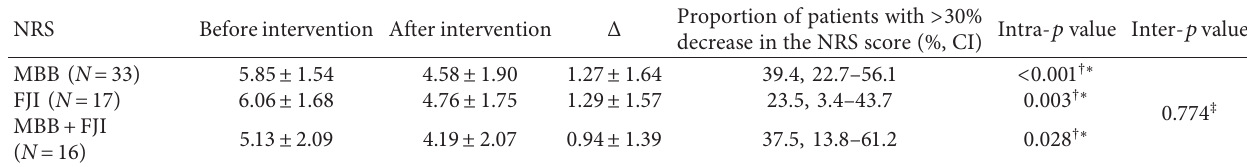
Table 2: Changes in the NRS score in the three groups before and after the intervention. NRS Before intervention After intervention Δ